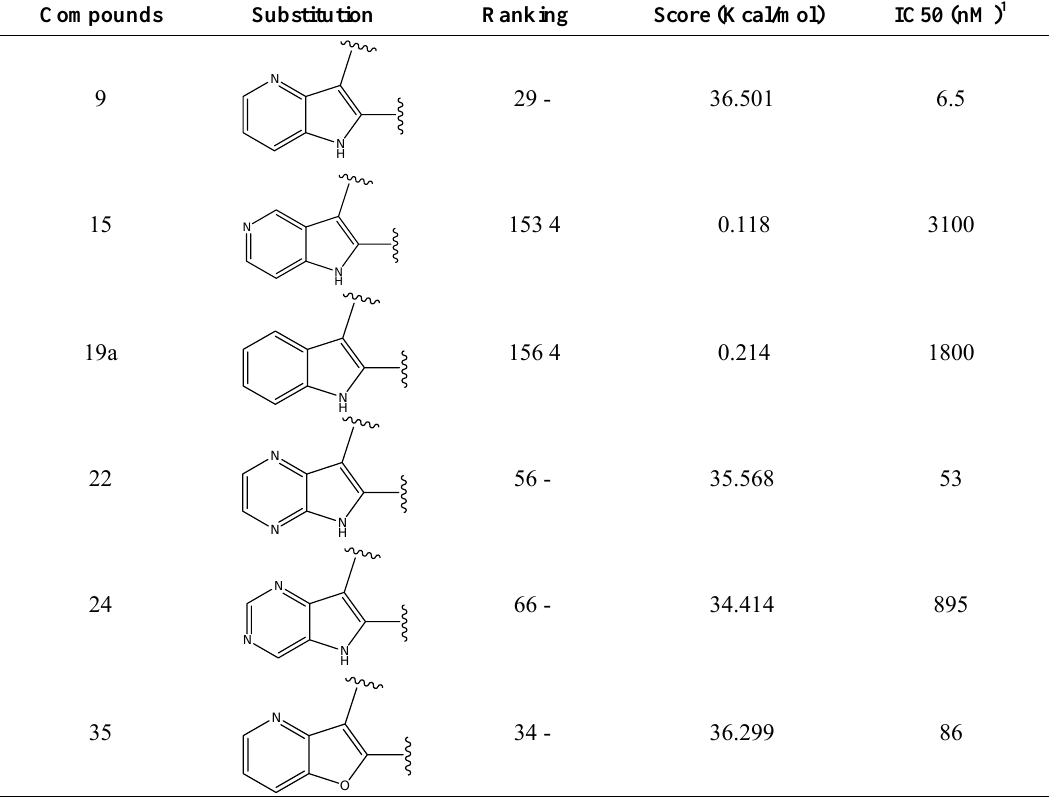
values for FPH 50